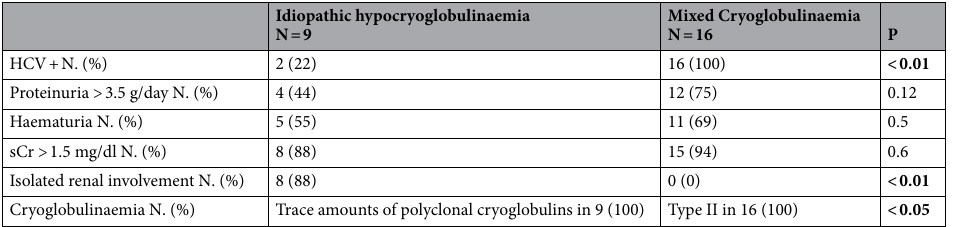
Table 1. Comparison of the main clinical and laboratory characteristics between patients with biopsy-proven renal involvement and Idiopathic hypocryoglobulinaemia vs. mixed cryoglobulinaemia. Statistically significant values are in